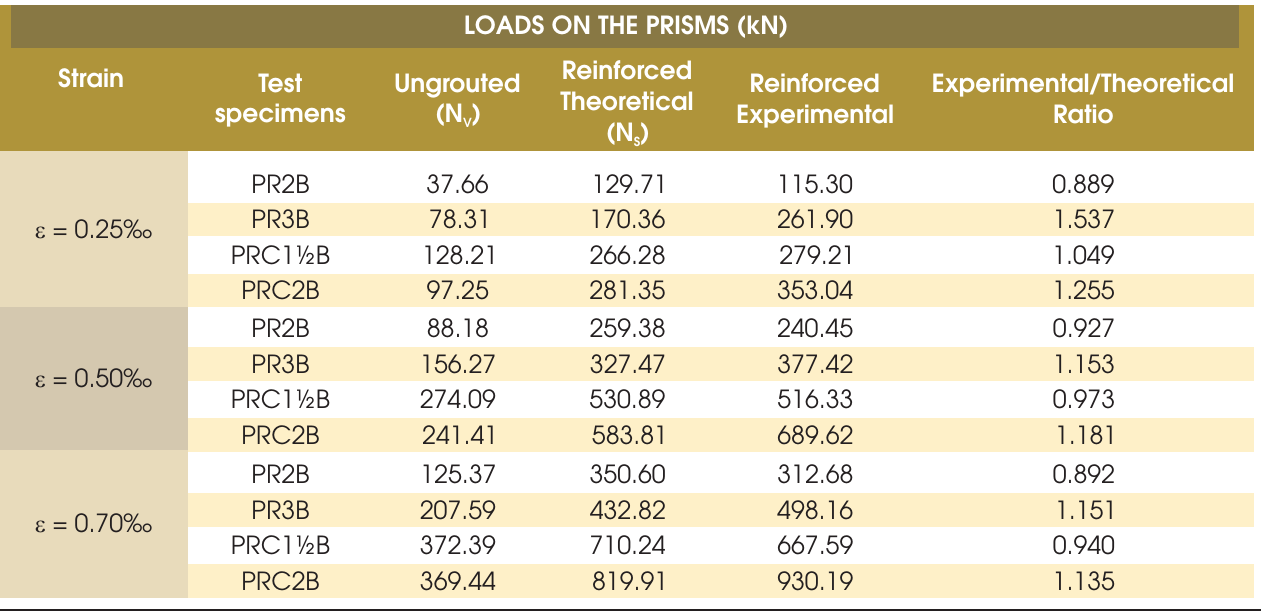
Table 7 – Comparison of mean theoretical and experimental loads for some strains (Model II) LOADS ON THE PRISMS (kN)